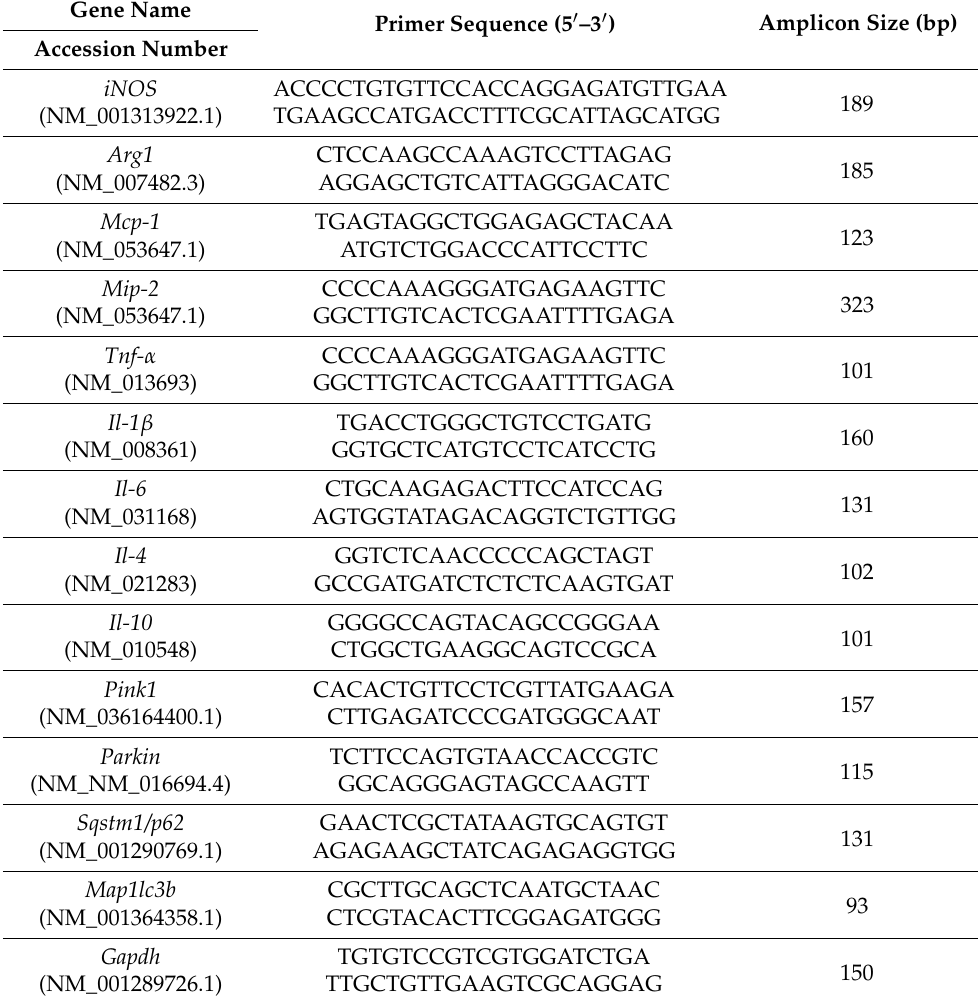
Table 1. Primer Sequences Used for the Amplification of Each